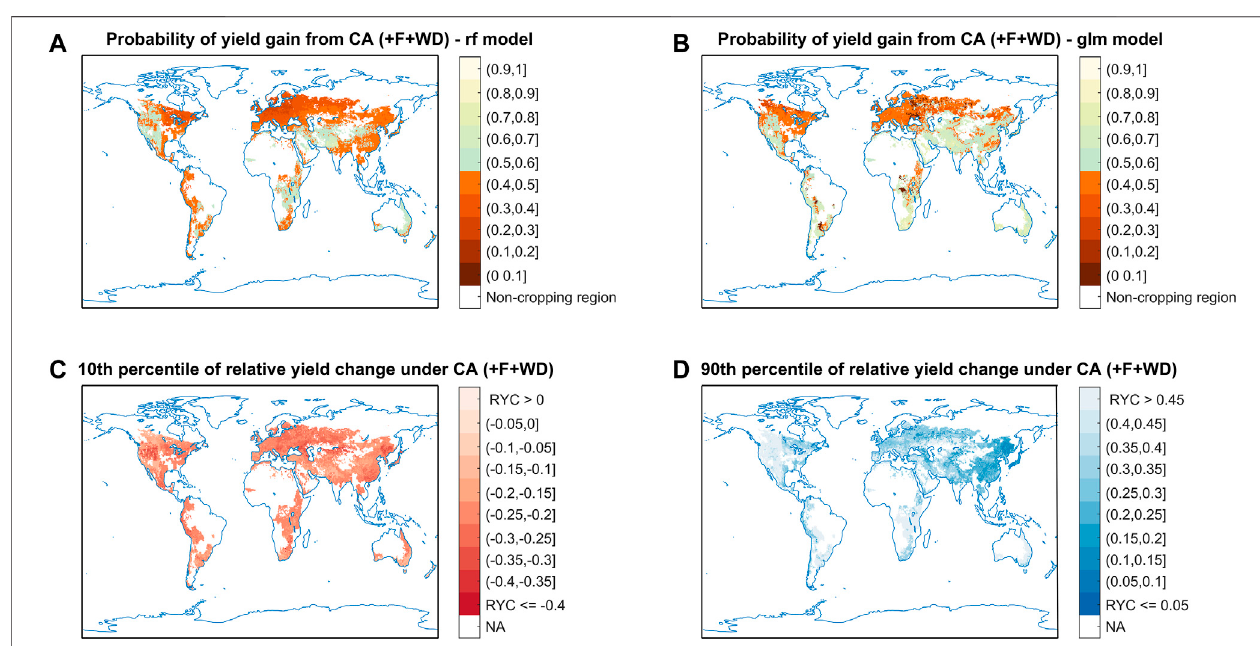
FIGURE5| Globalprojectionobtainedwiththealgorithmsofclassi fi cationandquantileregression.Plots (A,B) showthemapsofprobabilityofbarleyyieldgainwith CAvs.CTbasedonthebestclassi fi cation (RF)andtheworst(GLM)algorithms,respectively.Regionswithaprobabilityofyieldgainlowerthan0.5arehighlightedinred. Plots (C,D) showthemapsofrelativeyieldchangewithCAvs.CTunder10thand90thpercentiles, respectively,basedonQRFalgorithm.Therewasa90%chancethat the relative yield change will be higher than the ratio shown on the map in plot c, and conversely a 10% chance that the relative change will be lower.